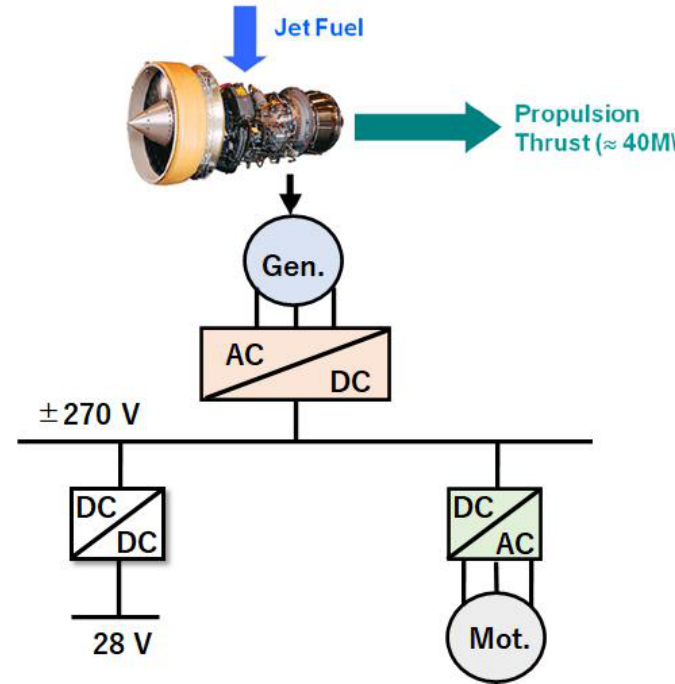
Figure 1. Generic illustration of future aircraft electrical network, including an high voltage dc (HVDC) power distribution bus: dedicated bi-directional DC-DC converters interface the 270 and 28 V buses; inverters cater for the AC loads (e.g., motors in pumps, actuators). Additional ports in the DC-DC converters may also be used to interconnect storage devices, with different voltage levels.